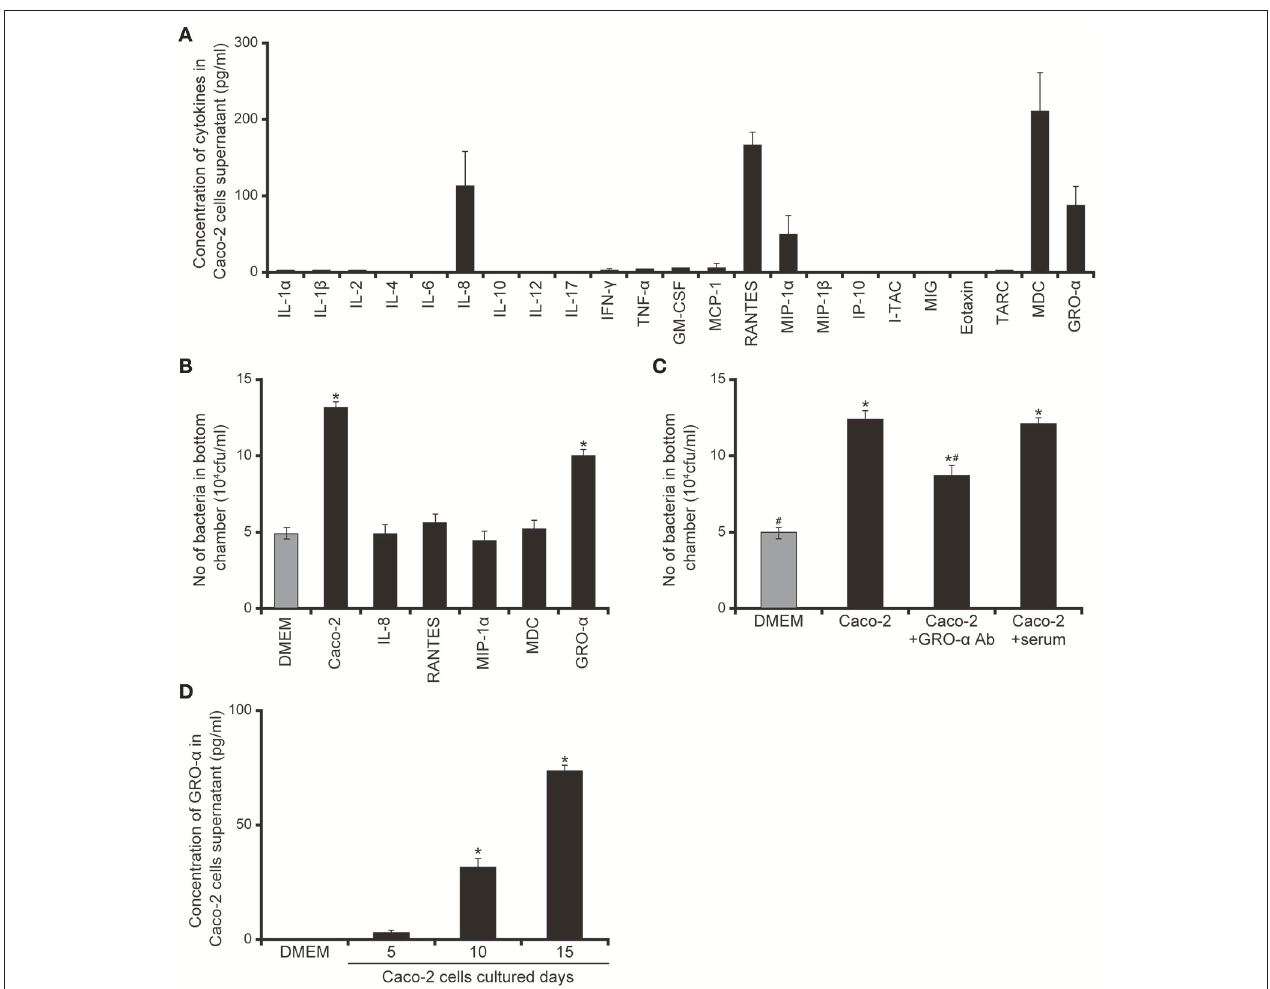
FIGURE 6 | Chemokines secreted by Caco-2 cells facilitate the penetration of the P. aeruginosa PAO1 strain through the mucin layer. (A) Cytokine levels in the 15-day Caco-2 cell supernatant were determined by enzyme-linked immunosorbent assay (ELISA). The graph shows the cytokine concentrations in the supernatant. Error bars indicate standard error ( n = 3). (B) The cytokines identified by the assay were placed in the bottom chamber of Transwell, as were unfiltered 15-day Caco-2 cell supernatant and Dulbecco’s modified Eagle medium (DMEM; control). The P. aeruginosa PAO1 strain was added to the top chambers and, after 3 h, the numbers of bacteria in the bottom chamber were counted. Error bars indicate standard error ( n = 3). * P < 0.05 compared with DMEM. (C) Caco-2 cells supernatant were pretreated for 30 min with anti-GRO- α antibodies (GRO - α Ab) (1 ml of Caco-2 cells supernatant/100 ng of antibody) or normal goat serum (serum) then inoculated onto the bottom chamber of Transwell. Error bars indicate standard error ( n = 3). * P < 0.05 compared with DMEM. # P < 0.05 compared with Caco-2 cell supernatant. * # P < 0.05 compared with DMEM and P < 0.05 compared with Caco-2 cell supernatant. (D) Growth regulated oncogene- α concentrations in the 5-, 10-, and 15-day Caco-2 cell supernatants were determined by ELISA. Error bars indicate standard error ( n = 3). * P < 0.05 compared with